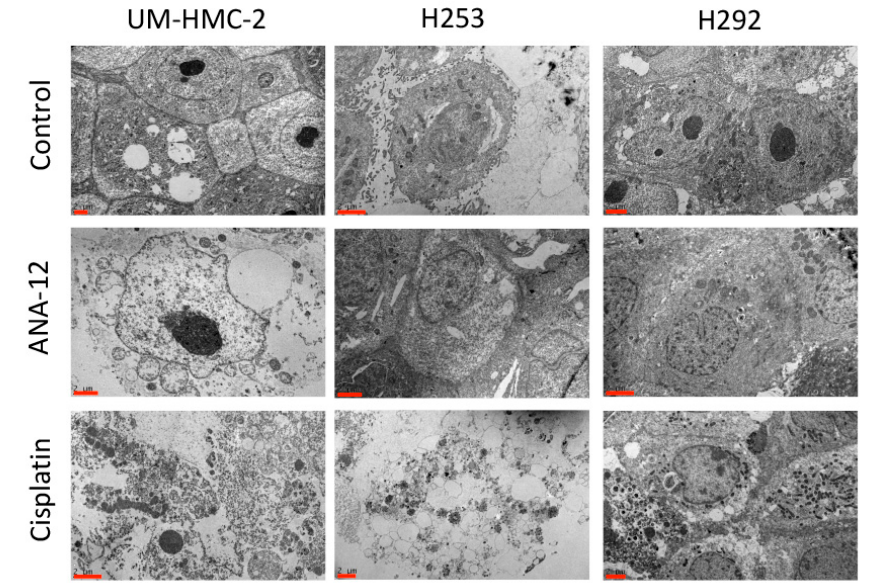
Figure 2. Representative images of MEC cells ultrastructural morphology following ANA-12 and cisplatin administration. Note, Cisplatin induced a high number of apoptotic changes such as decrease in cells size, “cup-shaped” chromatin condensation, convolution of the nuclear and cellular outlines, loss of cell contact, loss of specialized surface elements such as microvilli and cell–cell junctions, and ultimately cell fragmentation and formation of apoptotic bodies. Cytosolic constituents released into the extracellular space can be observed indicating a process of secondary necrosis. Scale bar—2 μ